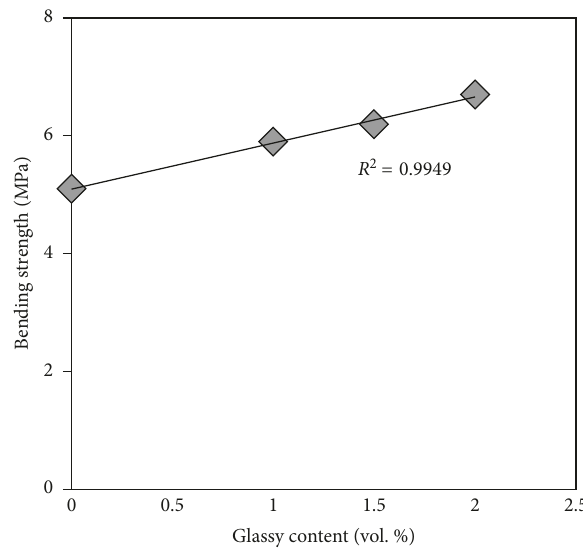
Figure 8: Linear correlation between bending strength and content of glass as percentage by volume in